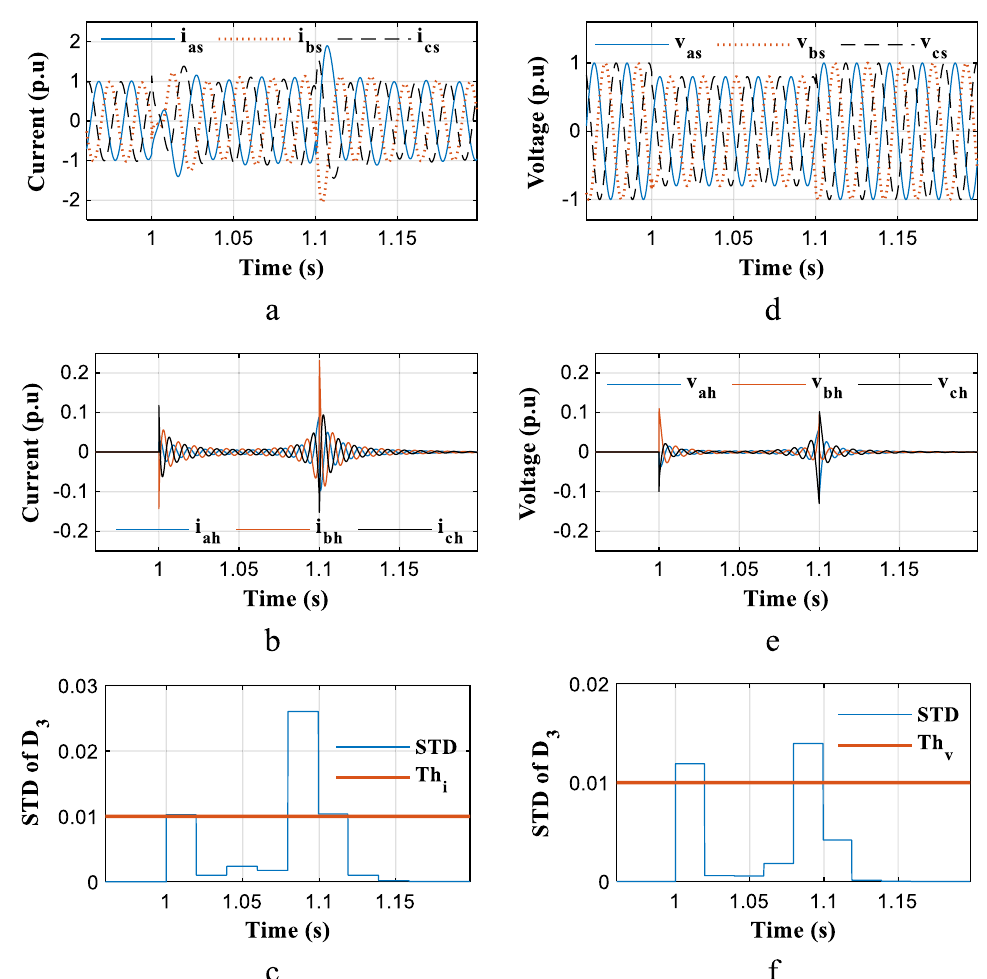
Fig. 10 Performance evaluation of the proposed criteria using simulation results for a voltage sag of 20%, a Three-phase stator current signals, b High-frequency components of three-phase stator current signals, c The current criterion, d Three-phase stator voltage signals, e High-frequency components of three-phase stator voltage signals, f The voltage